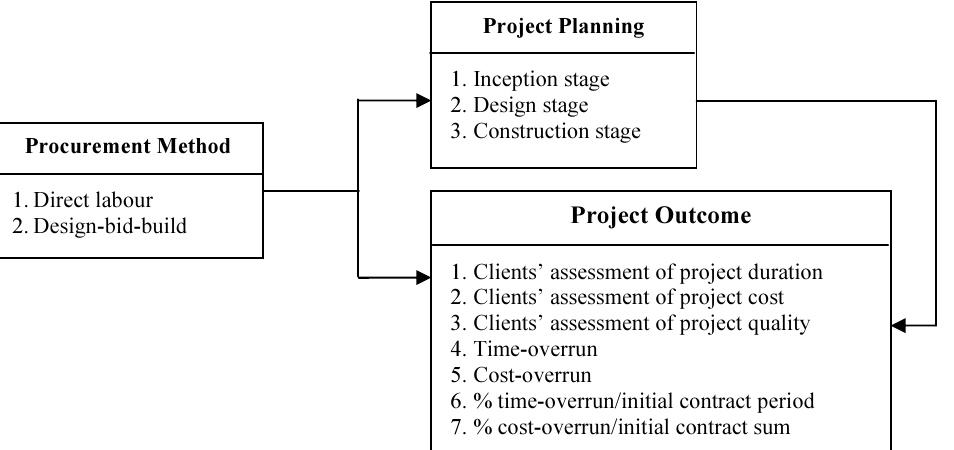
Fig. 1. Framework for comparing the level of planning and the outcome of projects procured by direct labour and design-bid-build procurement